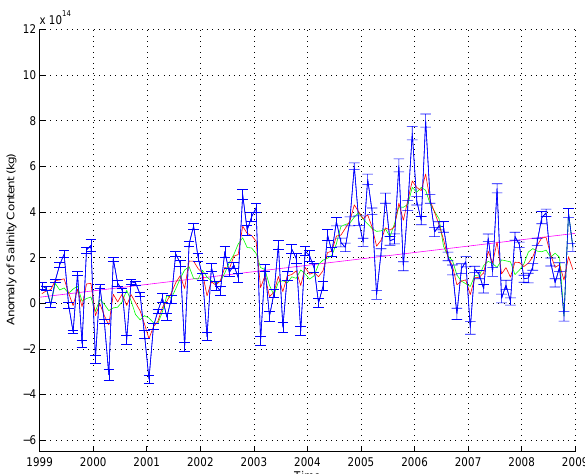
Fig. 11. SCD for the layer between 0 and 2000m. The vertical bars represent one standard deviation. Blue is SCD, green is a moving averaged SCD and red is the SCD filtered with a 7 point low pass filter. The magenta represents a linear